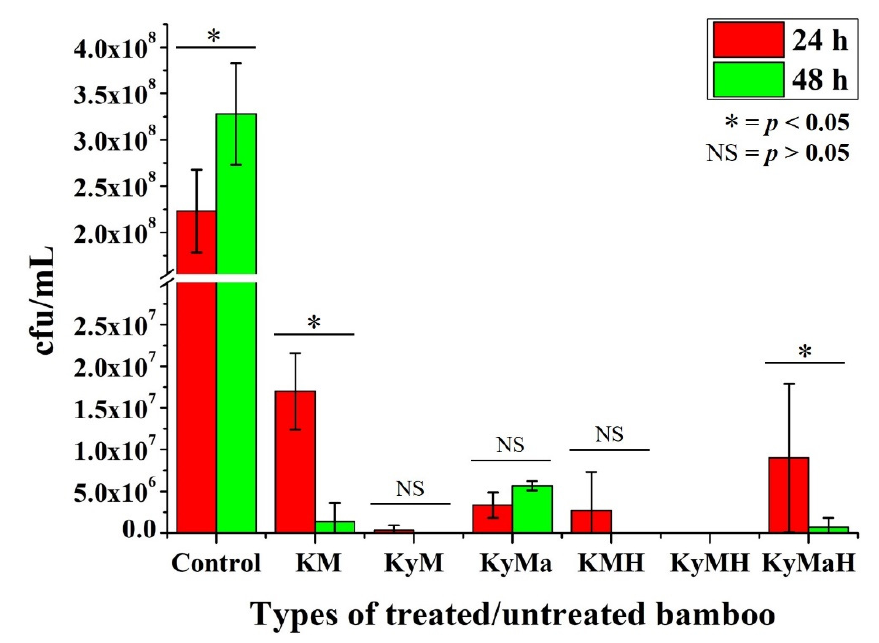
Figure 6. Colony-forming units (CFU) of various types of antibacterial agents of bamboo specimens of varying treatment modifications after in vitro testing with S. aureus for 24 h and 48 h periods (* statistically significant difference, NS = no significant difference).